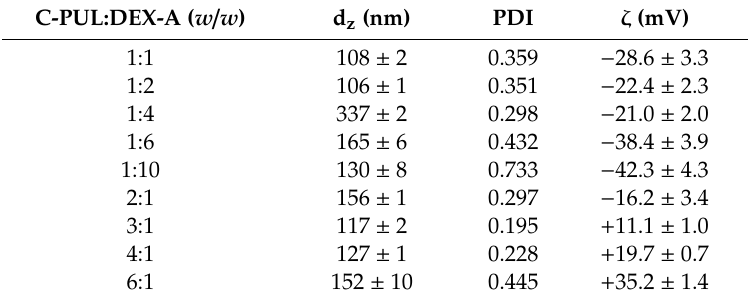
Table 1. Mean hydrodynamic diameter (d Z ), polydispersity index (PDI) and ζ potential of the NGs systems obtained at di ff erent polycation / polyanion